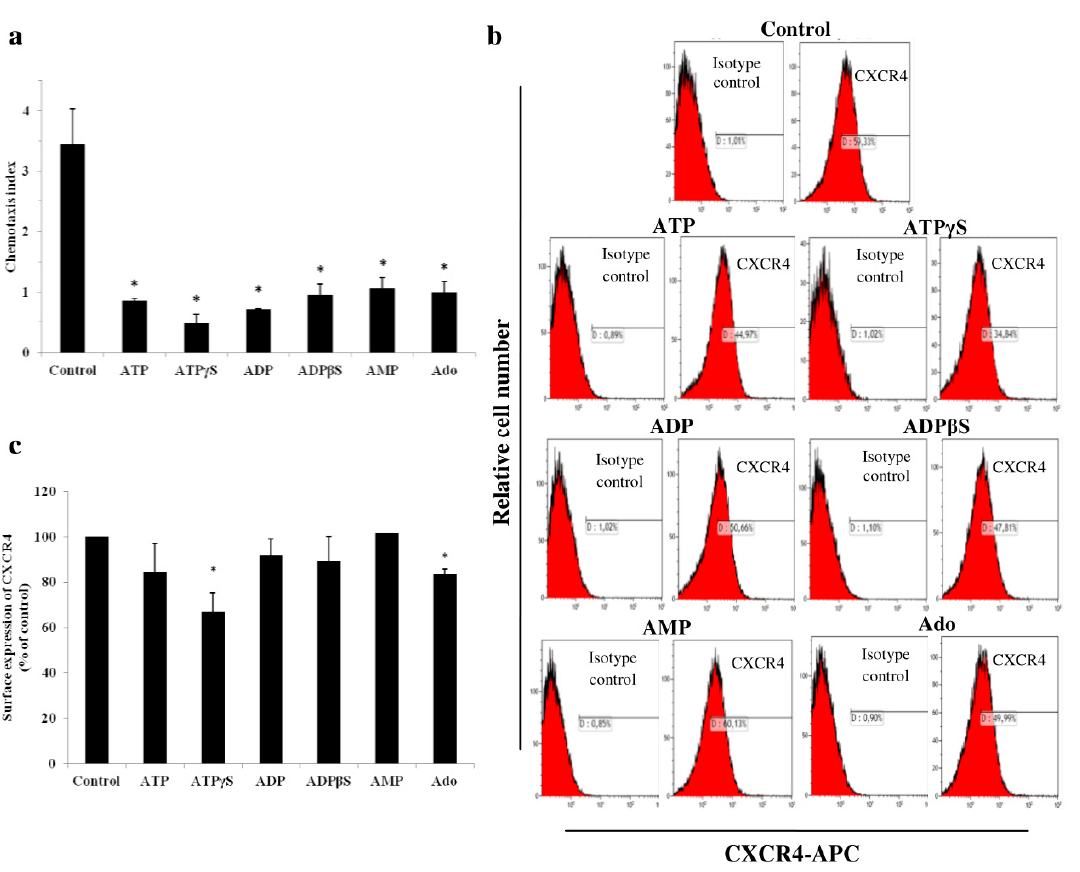
Figure 5. Adenine nucleotides and adenosine (Ado) modulate the stromal cell-derived factor-1/chemokine receptor type 4 (SDF-1/CXCR4) axis in THP-1 cells. ( a ) Chemotaxis of THP-1 cells towards SDF-1 was inhibited after 24 h of preincubation with 10 µM of adenine nucleotides or adenosine. The results are presented as the chemotaxis index. ( b ) Representative flow cytometric analysis of THP-1 cells stained using the APC-labelled mouse anti-CXCR4 antibody and the isotype control antibody after 24 h of incubation with 10 µM of adenine nucleotides or adenosine. ( c ) Effects of 10 µM of adenine nucleotides or adenosine on the surface expression of the CXCR4 receptor in THP-1 cells after 24 h of incubation. Data are presented as the mean ± SD of three different experiments. * p < 0.05 compared to the unstimulated control cell culture.